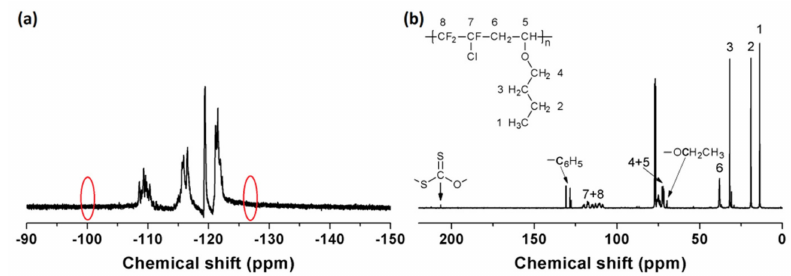
Figure 2. ( a ) 19 F and ( b ) 13 C NMR spectra of poly(CTFE-alt-BVE) (Sample P4).